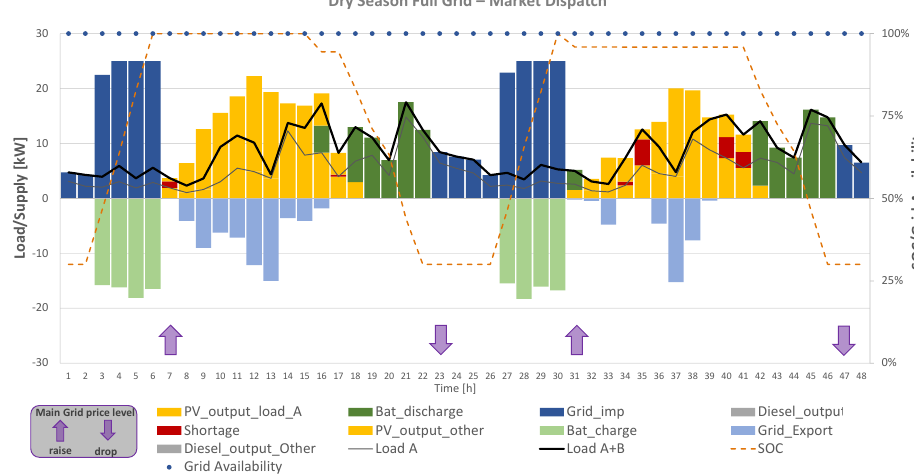
Figure 14. Market-based optimal dispatch for dry season full